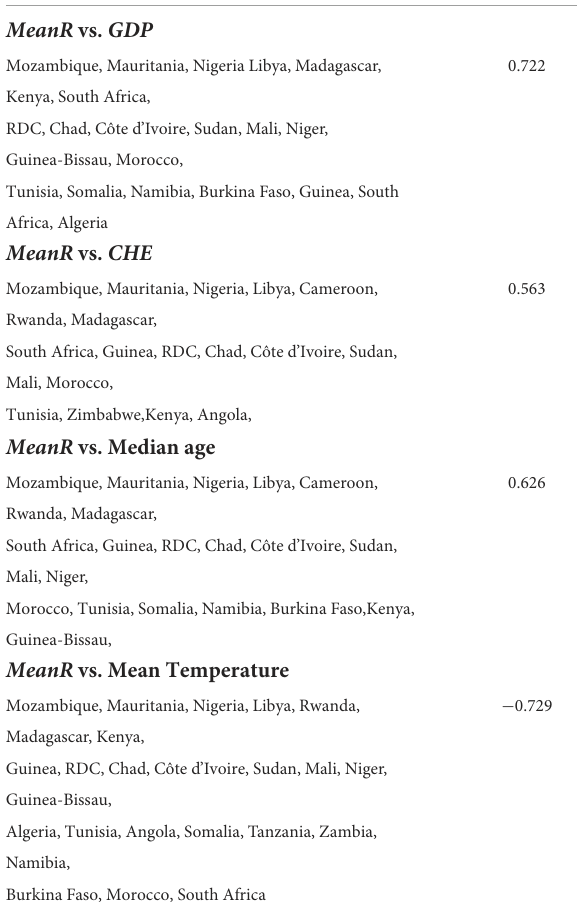
TABLE 4 Results of correlation analysis. Country